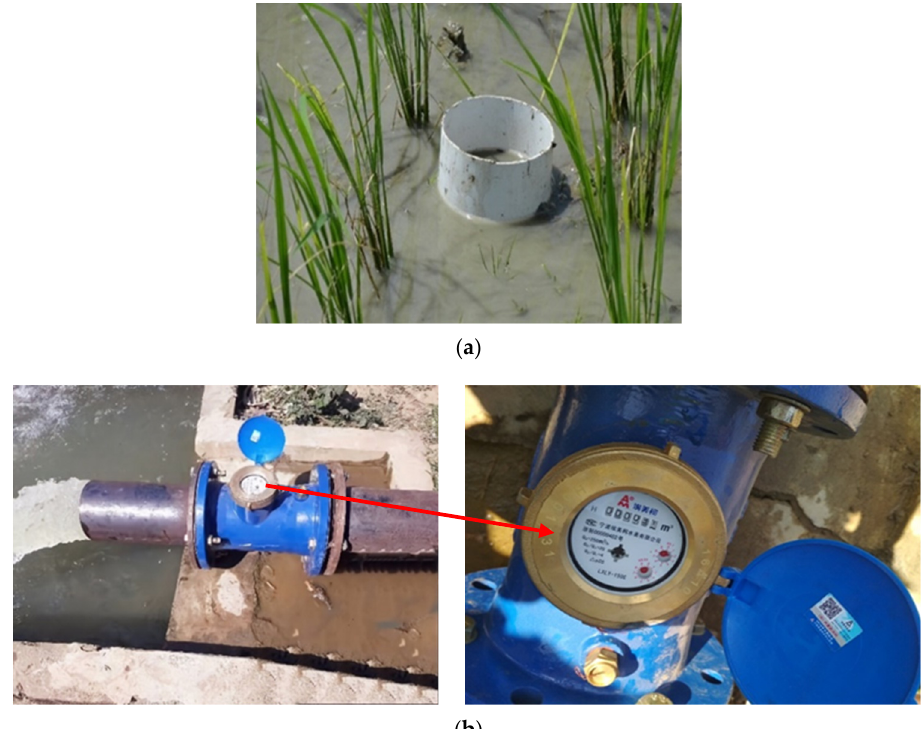
Figure 2. ( a ) Installed AWD pipe in the field; ( b ) installed water flow meter.